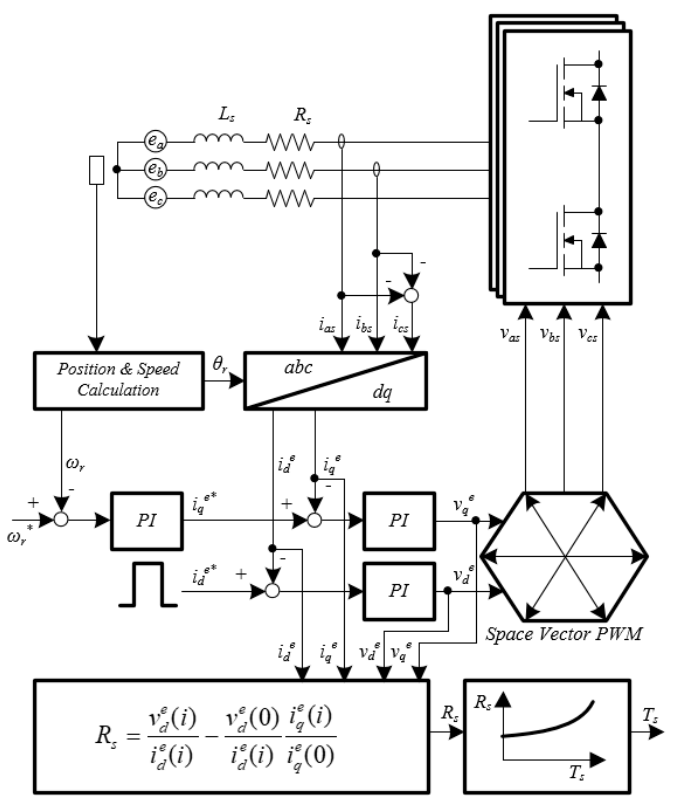
Figure 6. Proposed control block-diagram for stator winding temperature estimation.